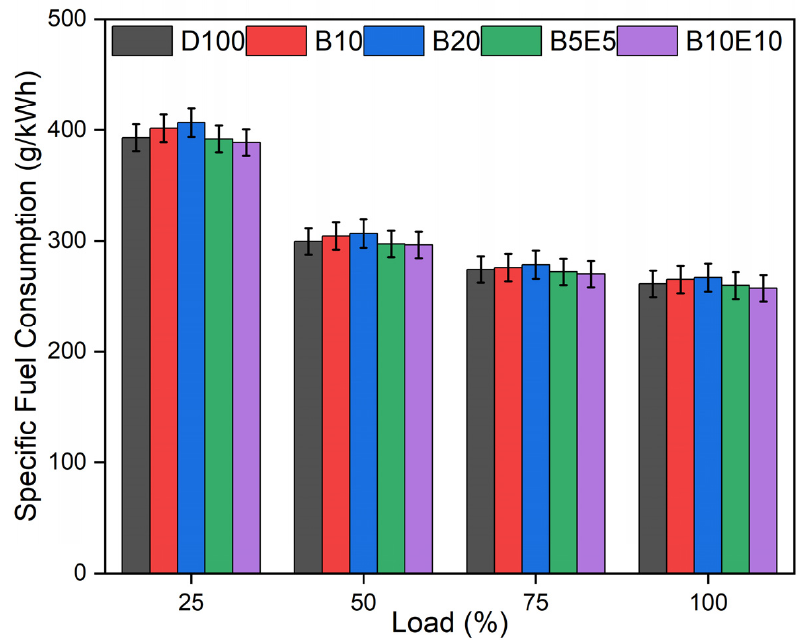
Figure 9. Variation of SFC of various fuel blends against engine load.